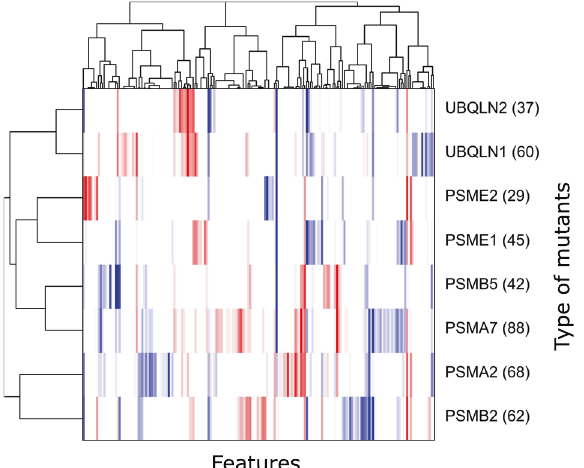
Fig. 4 Comparison of the mutants based on morphological pro fi les. Clustering of mutants (vertical) and features (horizontal) using the regression coef fi cients in the discriminative models. Red and blue colors in the heatmap represent positive and negative regression coef fi cients, respectively. Features not selected by L1 regularization were colored in white. Numbers described on the right side of gene names show the number of selected